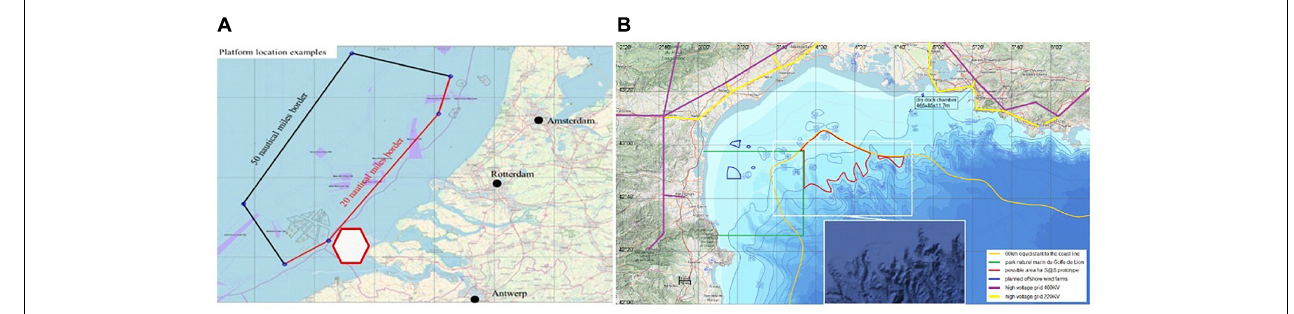
FIGURE 4 | Business case locations, North Sea (A) and Mediterranean (B)